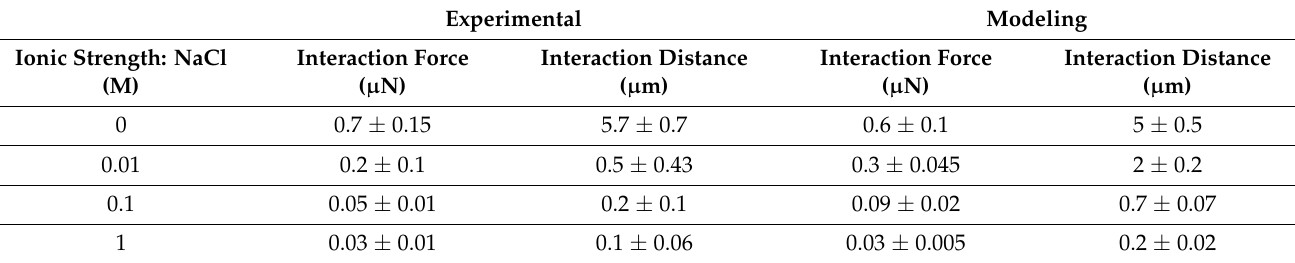
Table 2. Comparison of the repulsive force and distance measured or modeled between the silica surface and a 10 µ m borosilicate sphere, both of which are functionalized by APTES for different ionic strengths controlled by the addition of NaCl. The data are collected during three experimental campaigns. For every campaign, new bead and substrate are considered, and force is measured in 10 different locations on a